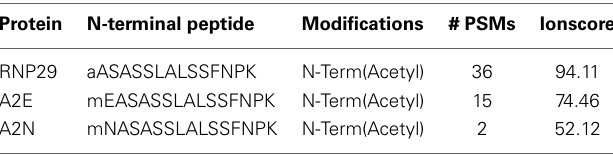
Table 2 | N-terminal modifications of RNP29 constructs identified in ppi2